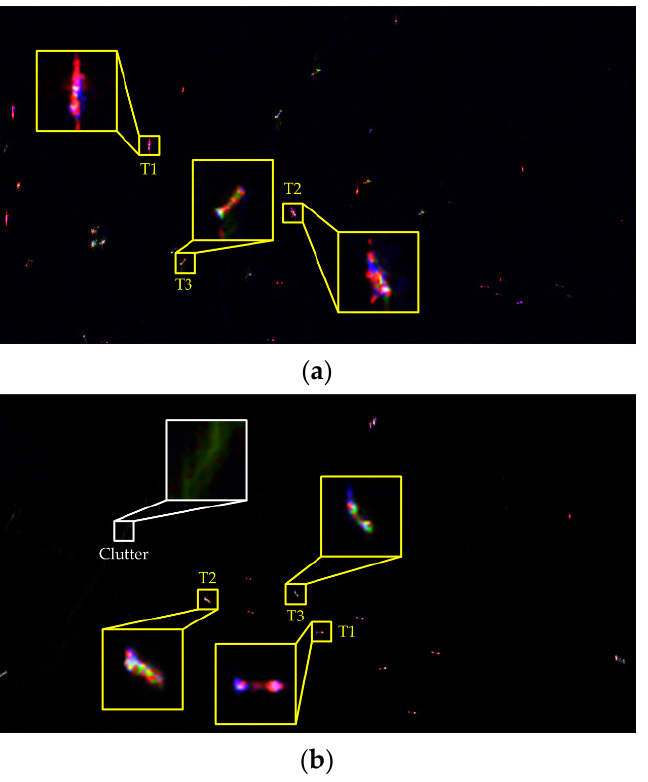
Figure 6. Fine eight-component decomposition results with several enlarged details (red: ship scattering, green: volume scattering, blue: surface scattering). ( a ) GF3 data. ( b ) AIRSAR data. As can be seen, ships exhibit various color distributions, indicating that ships with different orientations and structures have different scattering mechanism